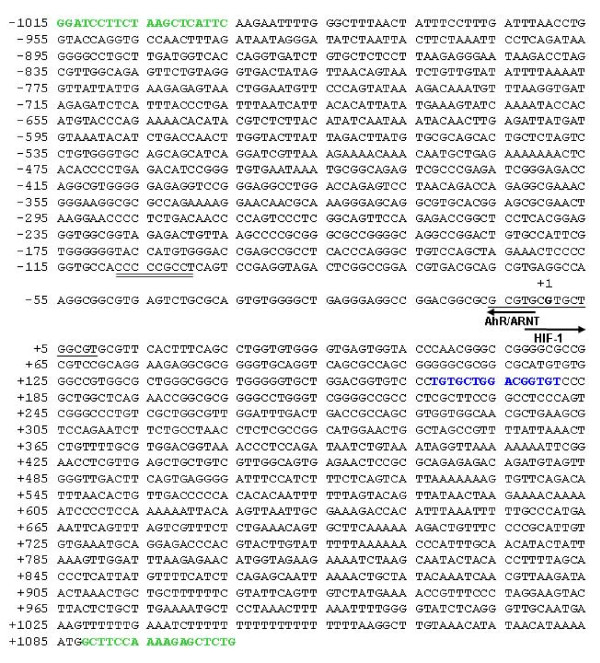
Nucleotide sequence of the promoter region of the human DJ-1 gene (GenBank Accession number AB045294) showing the positions of significant sites. The +1 indicates the transcription start site. The position of the 16 bp deletion sequence is indicated by a single underline and the Sp1 site by a double underline. The position of the 18 bp insertion/deletion polymorphism (g.168_185del) is indicated in blue font and the positions of the primers used to generate the luciferase constructs are shown in bold green font. The positions of putative cis-motifs (AhR/ARNT and HIF-1) present in the 16 bp deletion sequence are indicated by arrows.